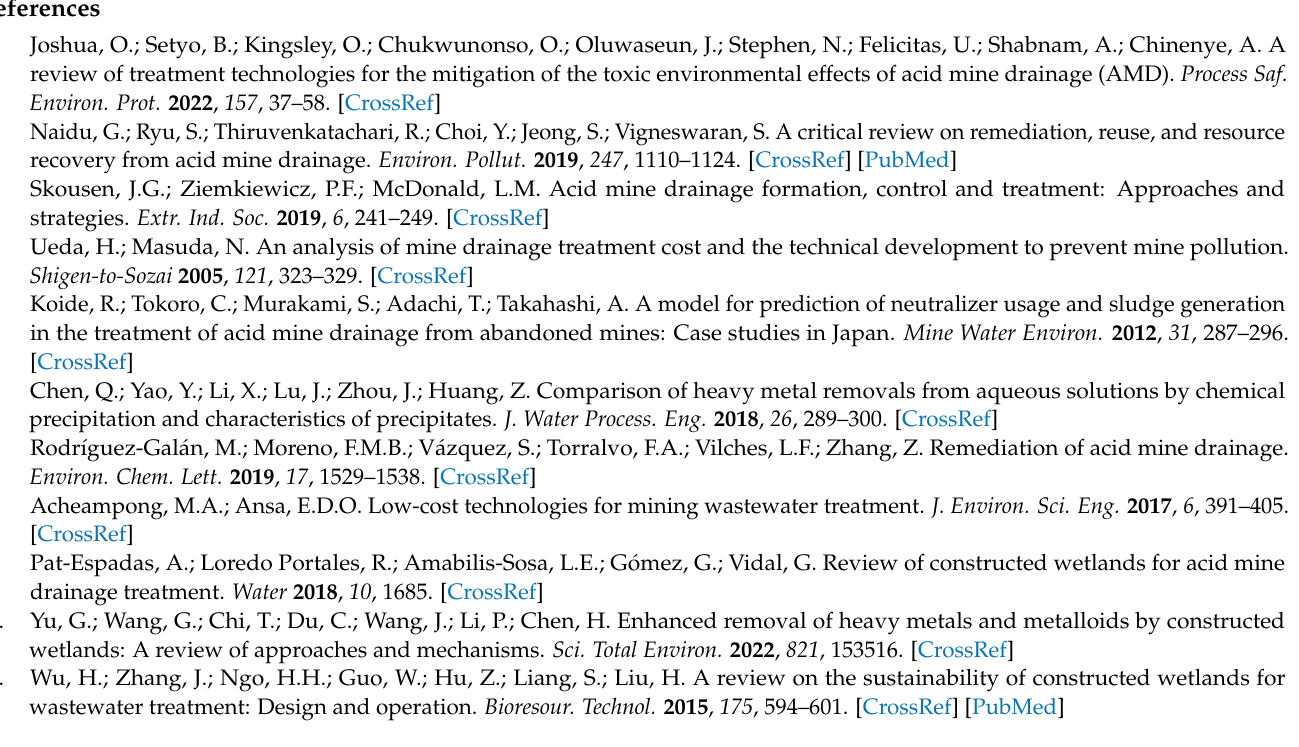
Figure S5: Sulfate concentration in influent and effluent for oyster shell (OS)/limestone